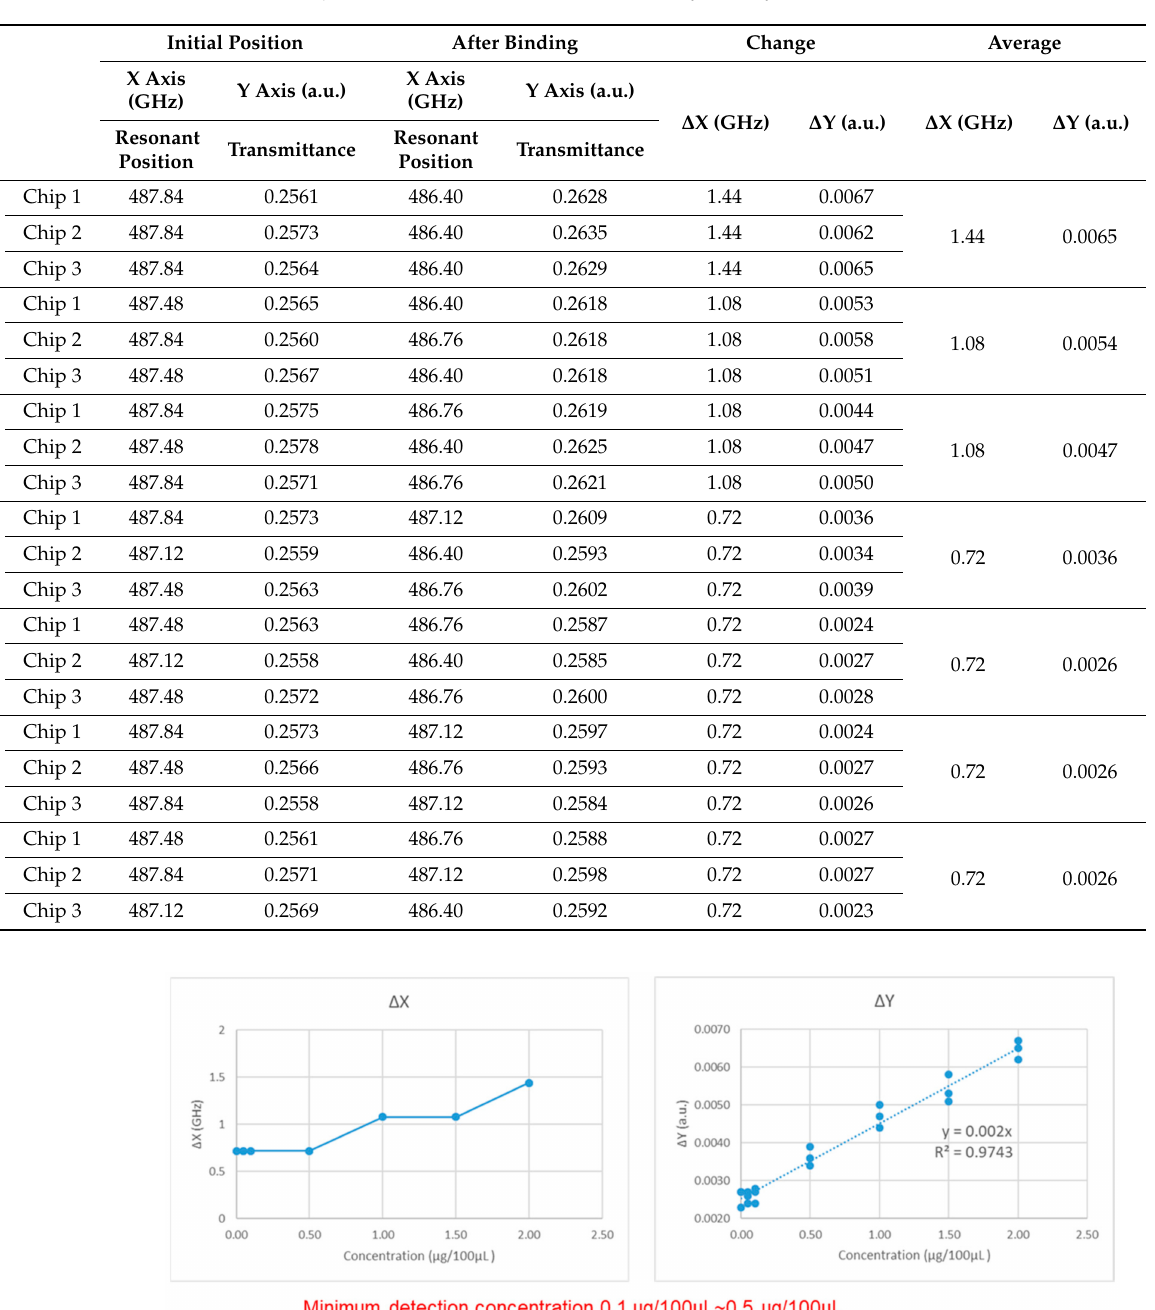
Table 2. X- and y -axis resonance shift and variation by VDI system.